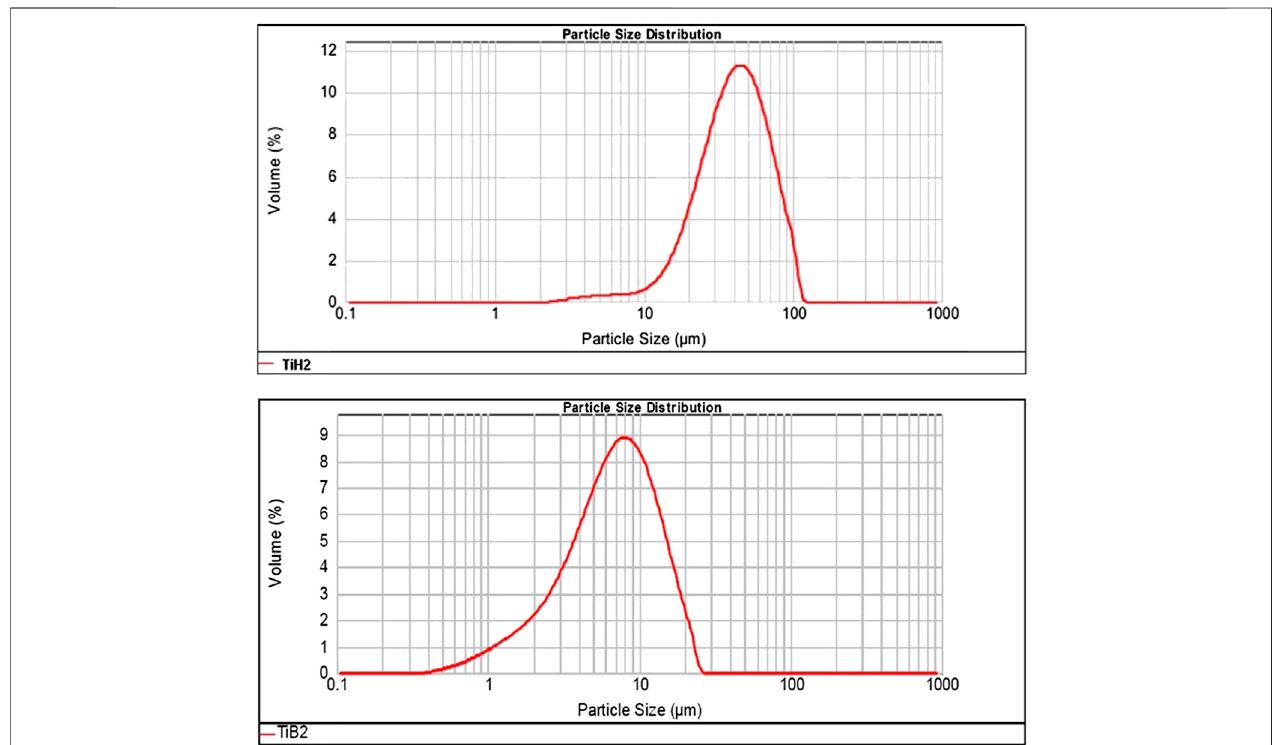
FIGURE 1 | Particle size distributions of starting powders: (A) TiH 2 and (B) TiB 2 .